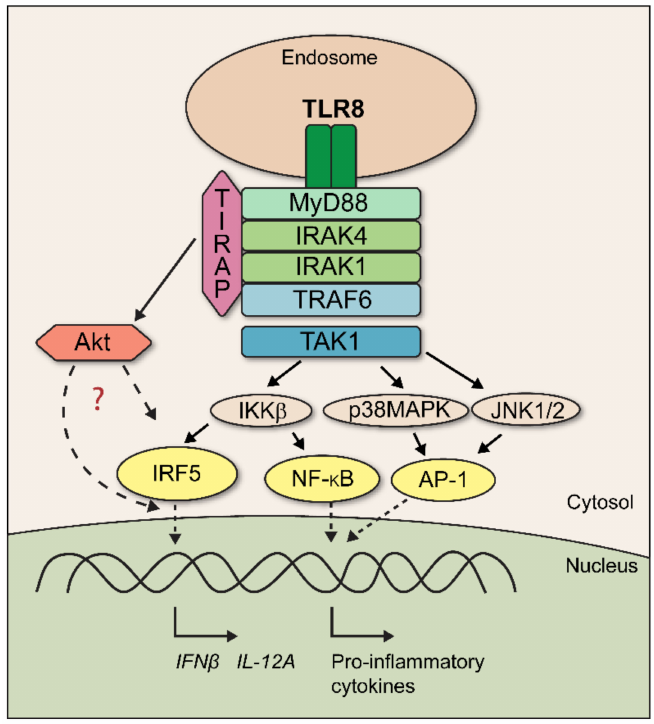
Figure 9. Model showing TIRAP involvement in regulation of TLR8 signaling. Recruitment of TIRAP to Myddosome promotes Akt activation and facilitates nuclear translocation of IRF5 as well as expression and secretion of IRF5-dependent cytokines IFN β and